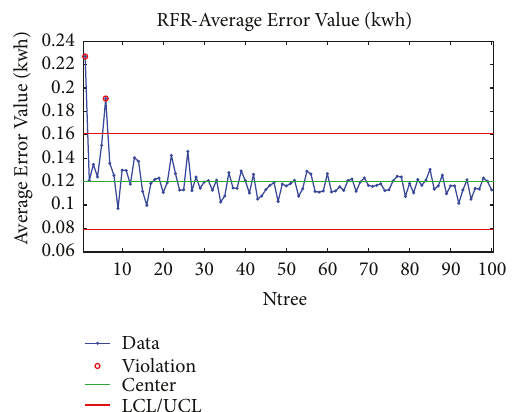
Figure 7: The error values at different Ntrees.